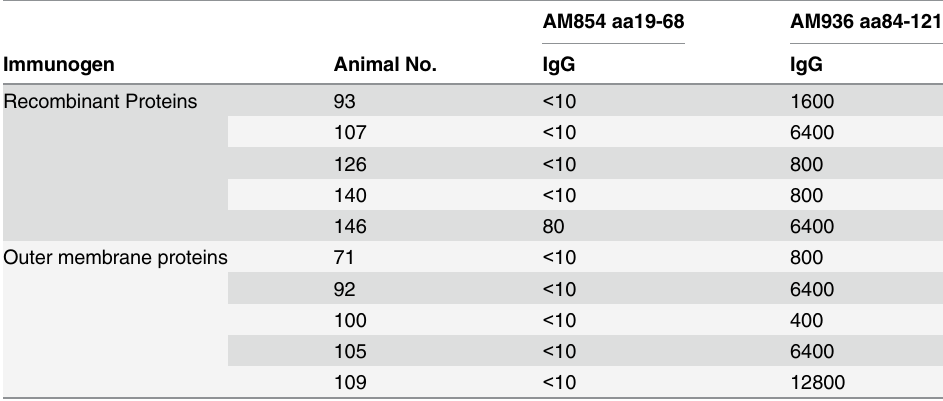
Table 4. IgG directed against predicted host cell binding domains of AM854 and AM936 following immunization with recombinant proteins or purified outer